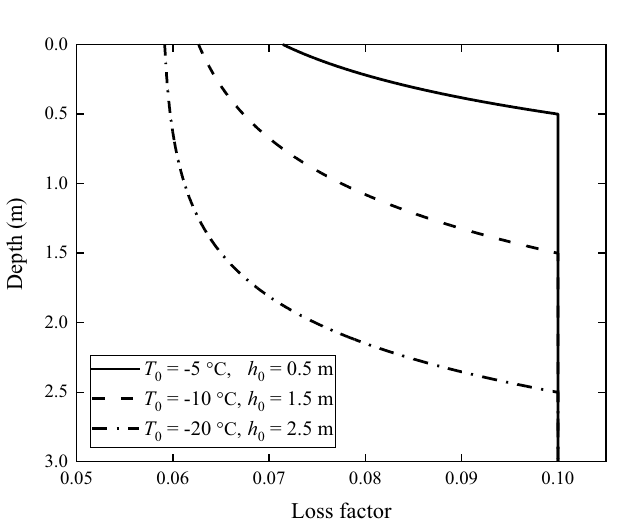
Figure 4. Loss factor of the frozen ground as function of